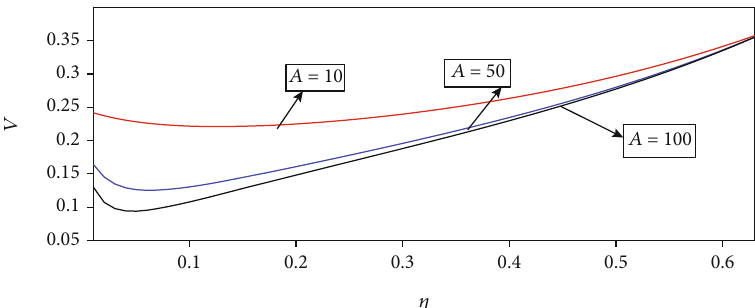
Figure 10: Plots of smallest eigenvalue V (Equation (37)) versus η for r = 0 : 5 and κ = 0 : 8 and for di ff erent values of linear gain coe ffi cient.